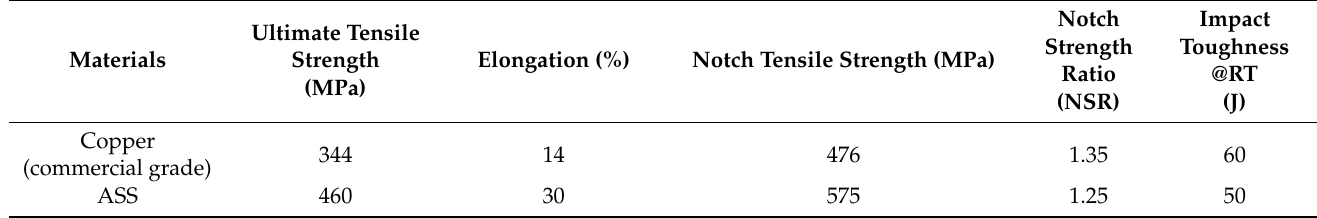
Table 2. Base metals’ mechanical